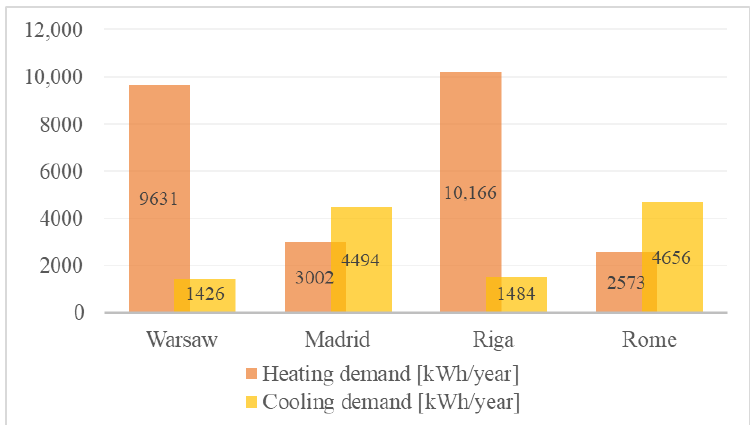
Figure 5. Results of annual heating and cooling demand. and Riga and between Madrid and Rome. The highest value of heating demand was achieved in Riga, while the lowest was recorded in Rome. The difference was 75%. The highest value of cooling demand was obtained in Rome, while the lowest was in Warsaw. Riga, and it was 38% more than in Rome, where the demand was the lowest. analyzed cities are summarized in Table